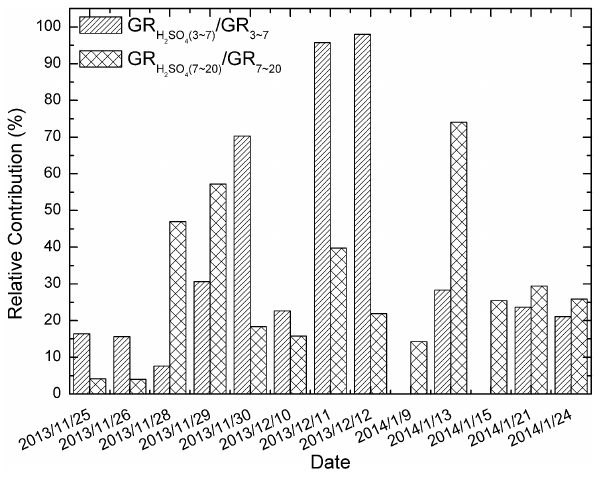
Figure 6. Relative contribution of sulfuric acid to growth of par- ticles in the range of 3–7 and 7–20nm, respectively, on each NPF